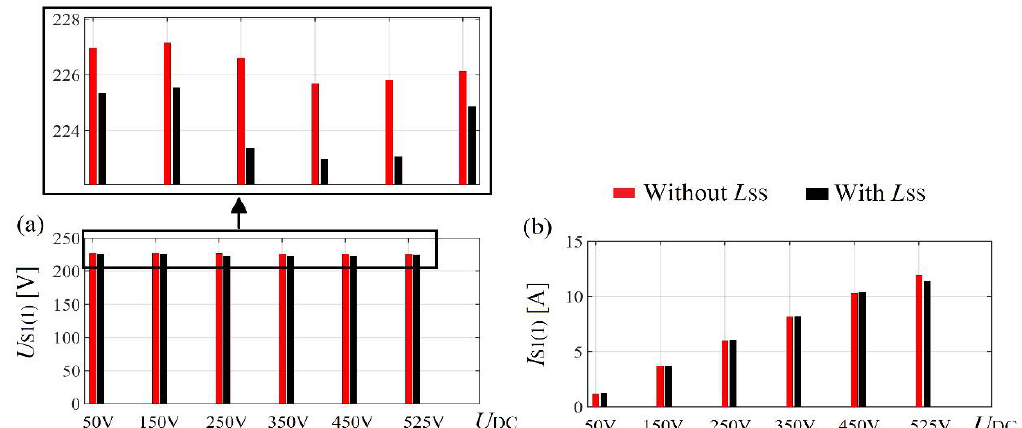
grid current THD ( b ).